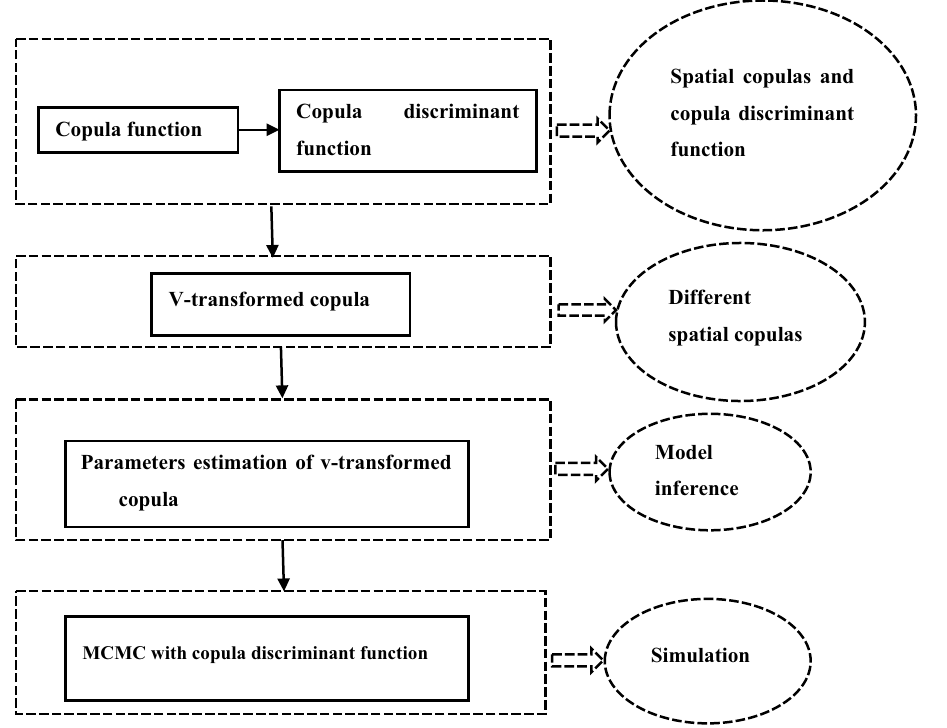
Figure 7. Flowchart of the proposed model and method for